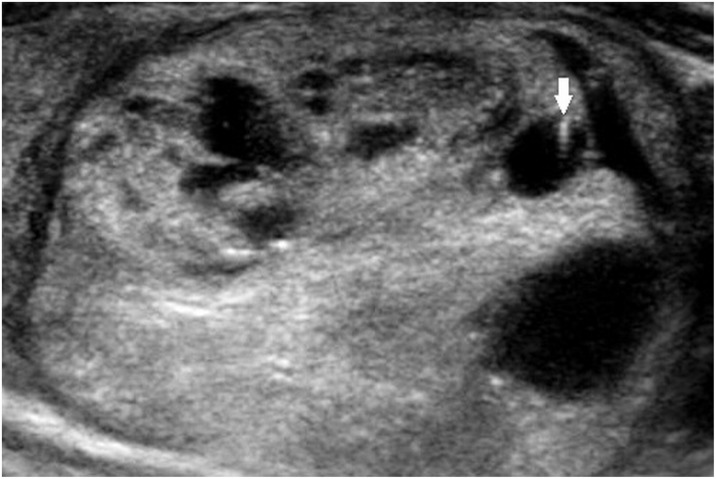
A 41-year-old man with multinodular goiter.Longitudinal sonogram shows an 36-mm, smooth, mixed isoechoic nodule in the right thyroid lobe. Echogenic focus is located at the margin of solid component (solid arrow); comet-tail artifact is located within the cystic component (Type 2).